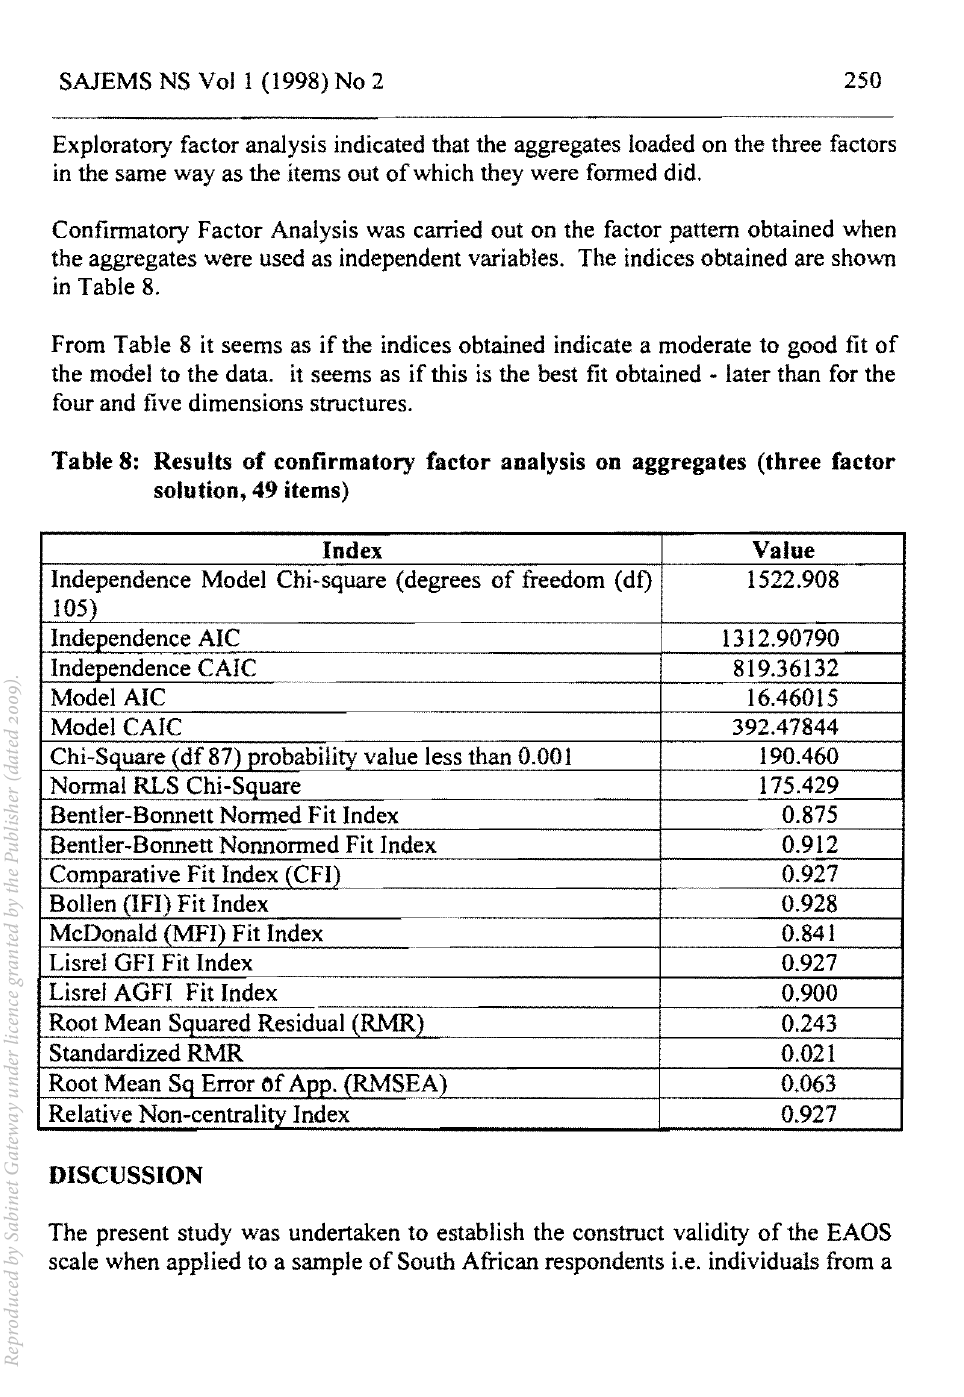
Table 8: Results of confirmatory factor analysis on aggregates (three factor solution, 49